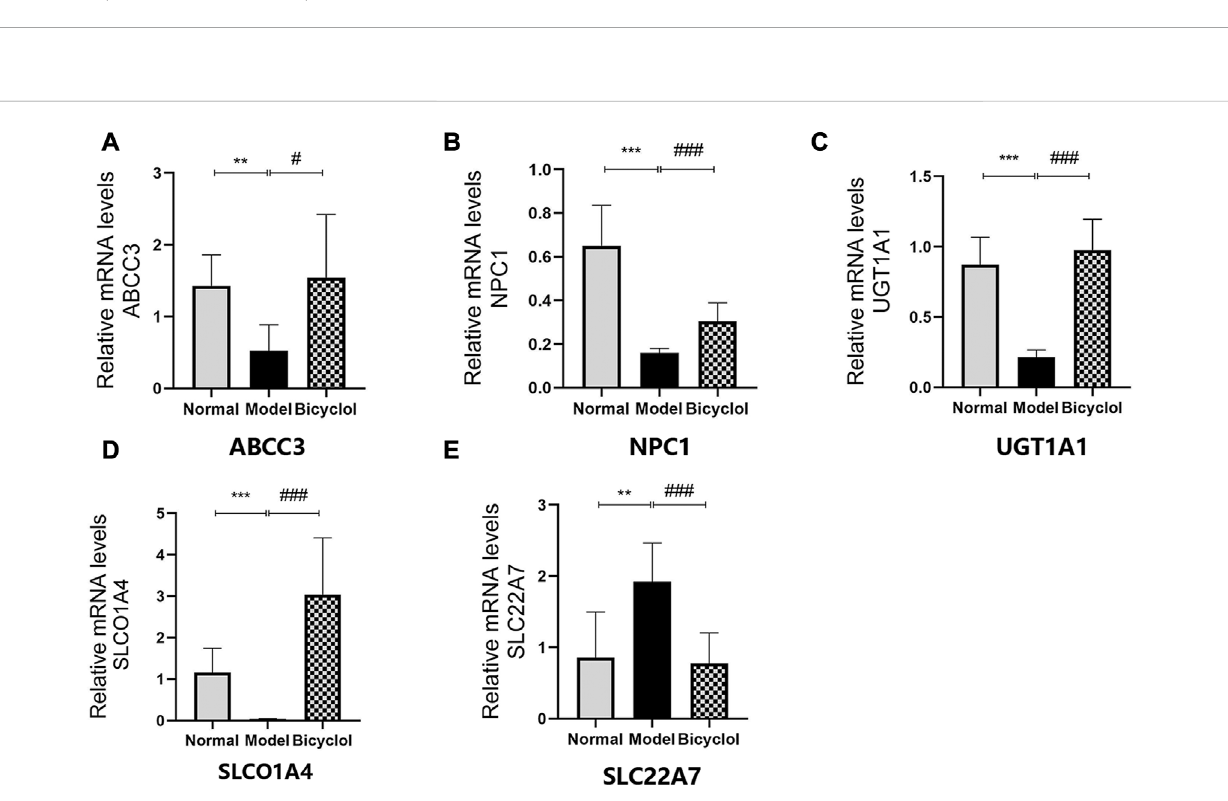
FIGURE 8 Expression of the genes involved in bile acid metabolism. Relative mRNA levels of (A) ABCC3 (n = 6), (B) NPC1 (n = 8), (C) UGT1A1 (n = 8), (D) SLCO1A4 (n = 8), (E) SLC22A7 (n = 8). ** p < 0.01 vs Normal, *** p < 0.001 vs Normal, # p < 0.05 vs Model, ### p < 0.001 vs